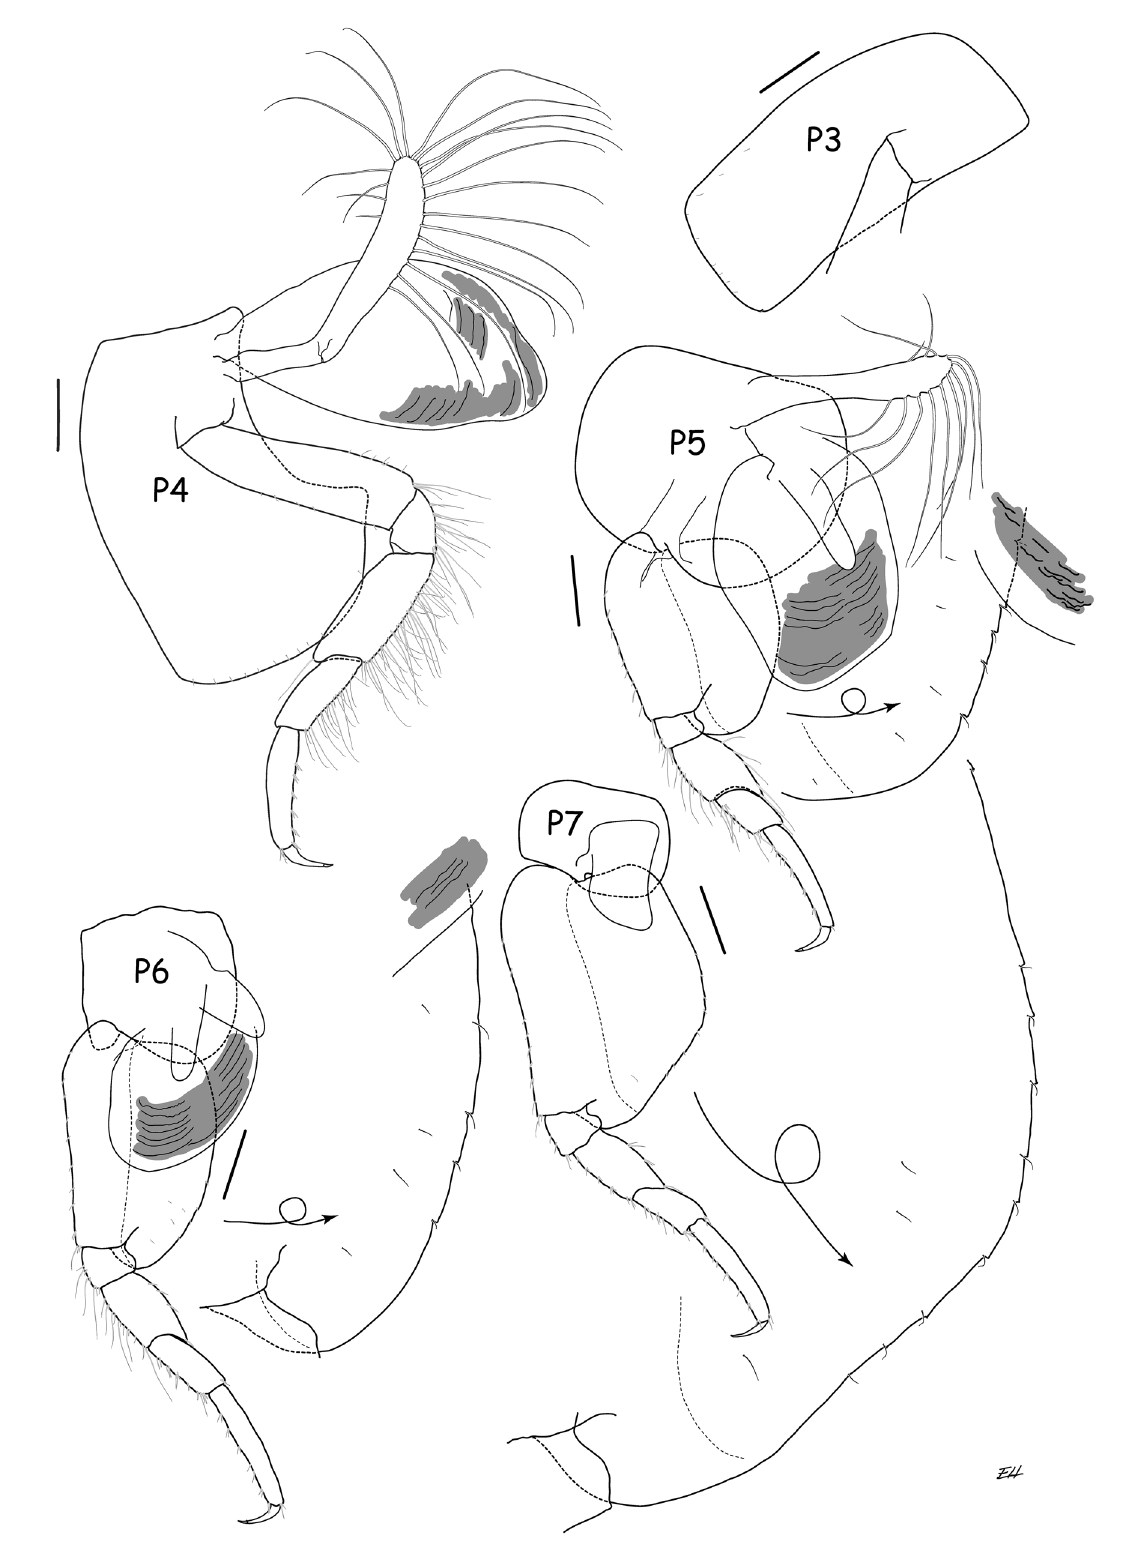
Fig. 32. Abyssorchomene shannonae sp. nov., holotype, ♀, 12 mm (ZMH K-61209). Scale bars = 0.5